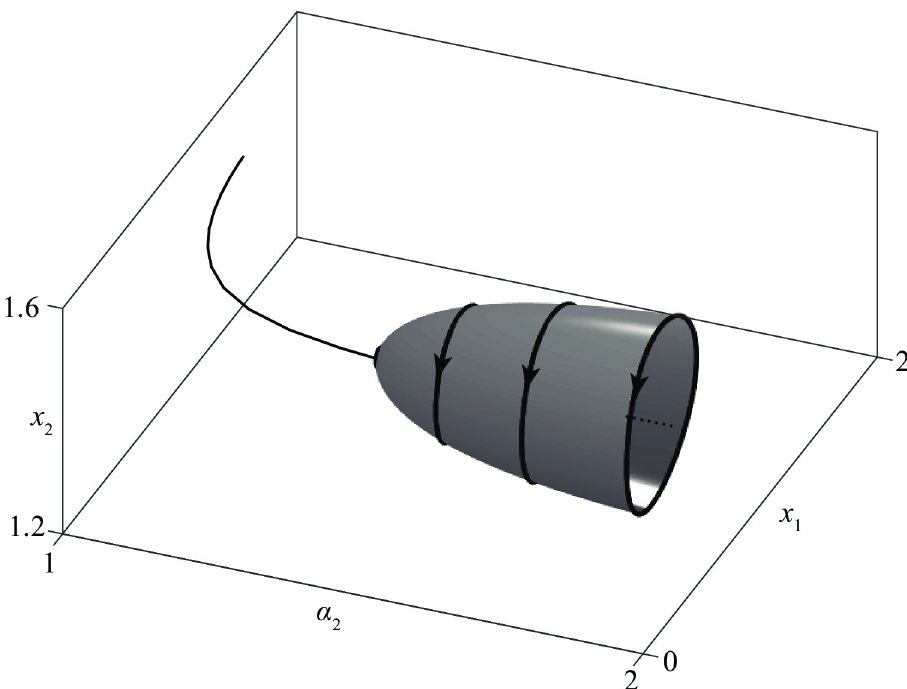
Fig 24. The influence of undetectability of the A group on the stalemate of a D—A conflict.